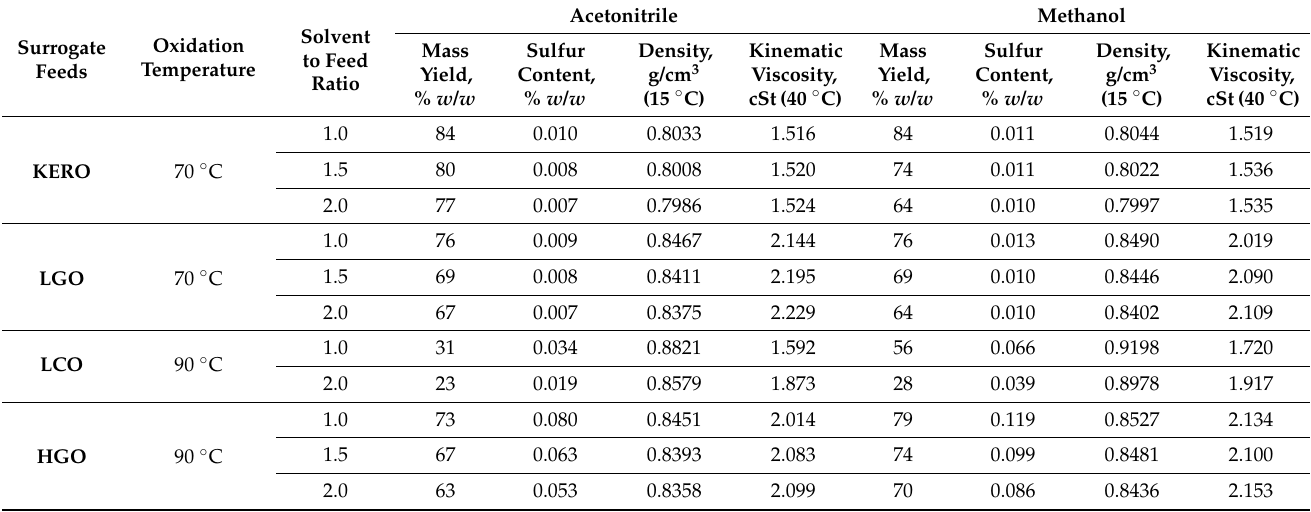
Table 5. Properties of the oxidized surrogates’ supernatants after their treatment with conventional